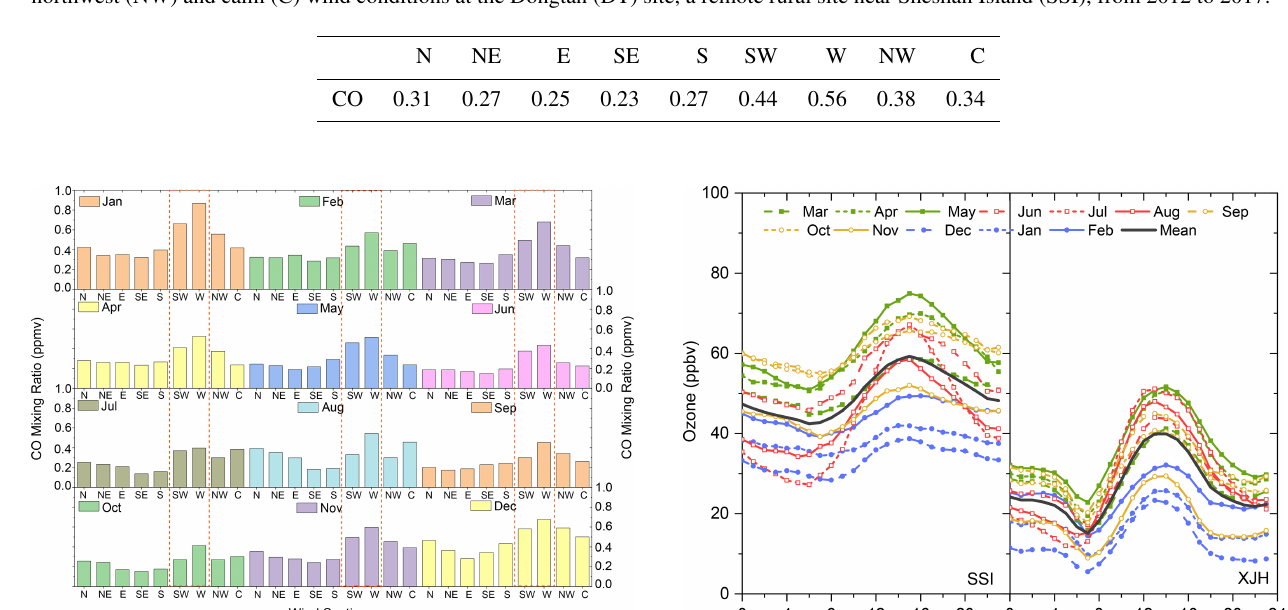
Table 1. Mean CO mixing ratios (ppmv) under north (N), northeast (NE), east (E), southeast (SE), south (S), southwest (SW), west (W), northwest (NW) and calm (C) wind conditions at the Dongtan (DT) site, a remote rural site near Sheshan Island (SSI), from 2012 to 2017.